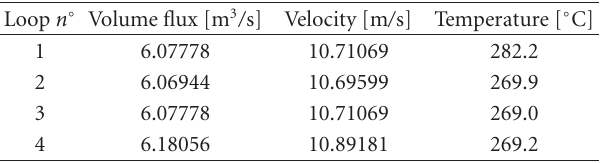
Table 1: Inlet boundary